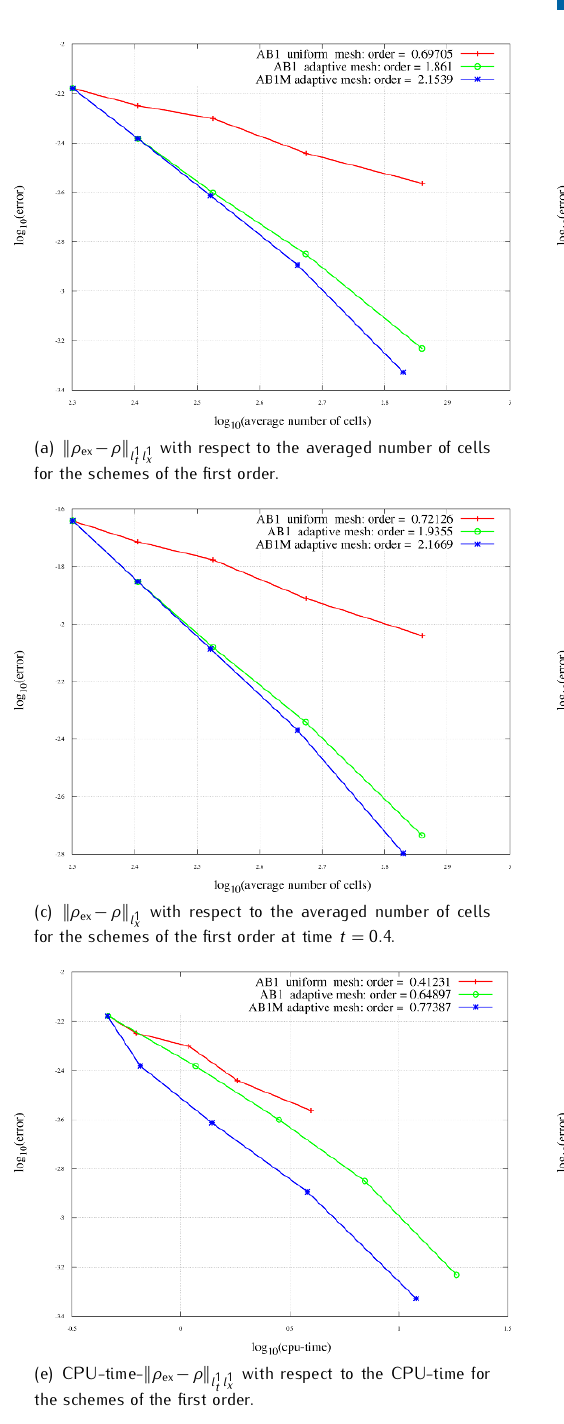
Figure 8. Sod’s shock tube problem: numerical